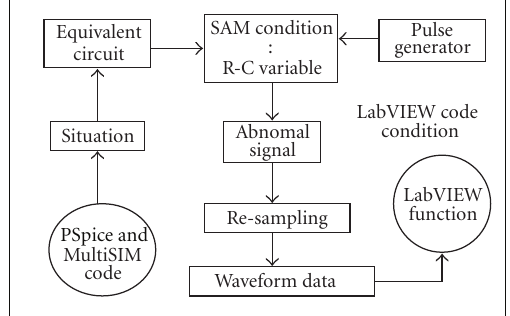
Figure 7: Block diagram for one body order simulation system.